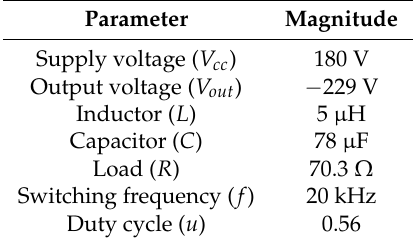
Table 2. Parameters of the Buck-Boost converter.